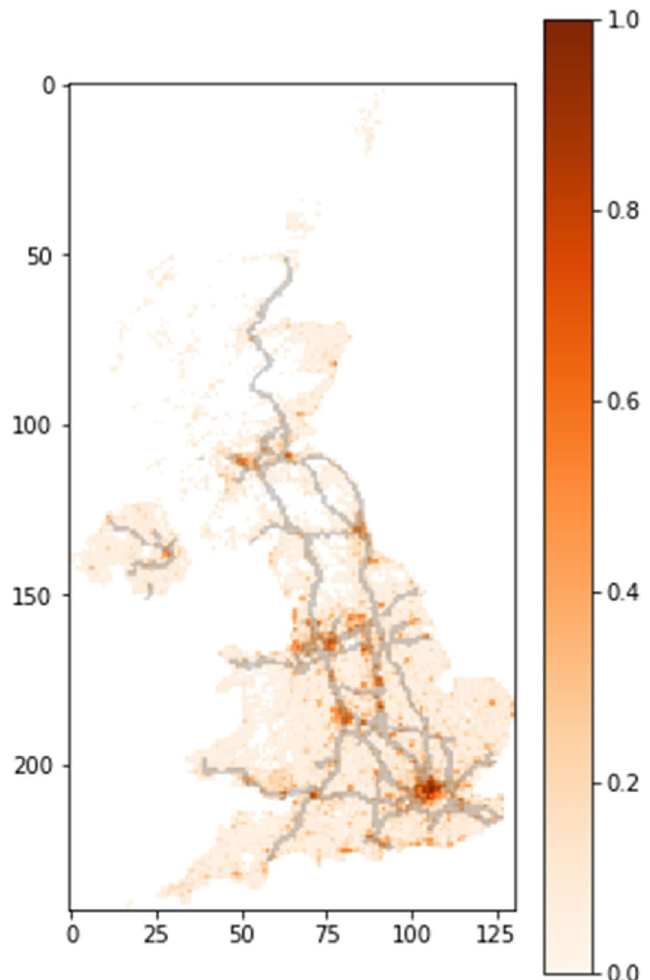
Figure 2. UK normalized population density and main routes map. The map is divided in a grid of squares of 25 km 2 . The map was generated using custom code 21